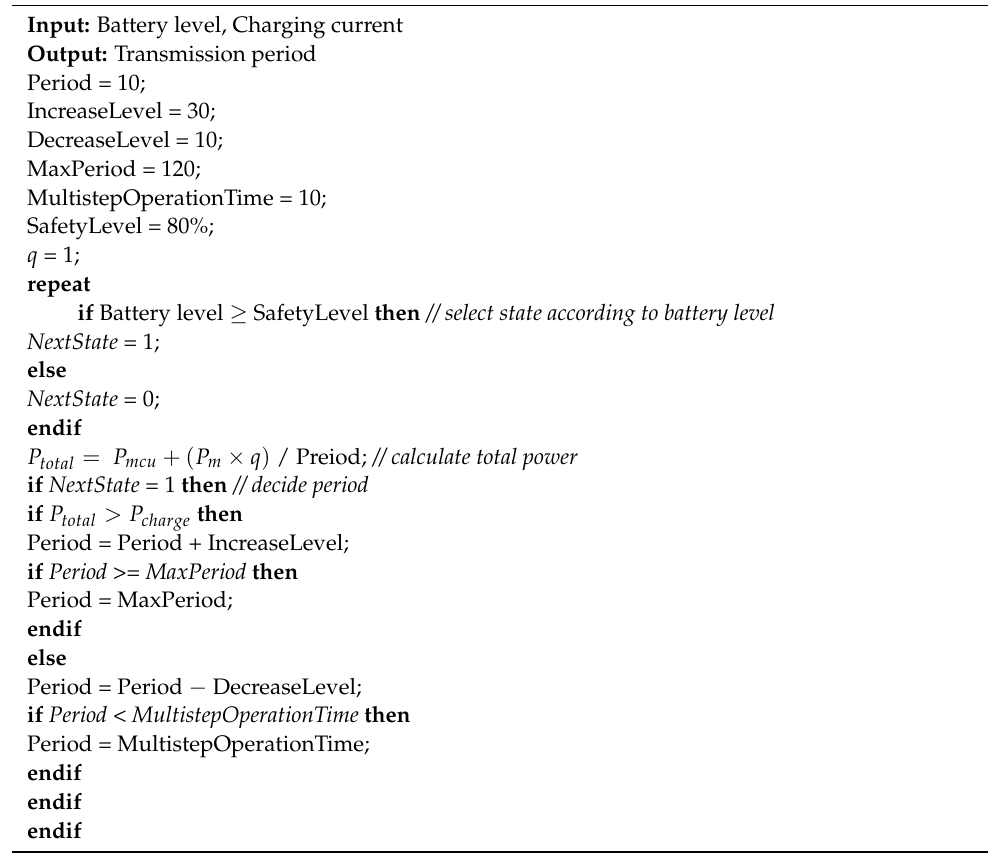
Algorithm 1 : Period of computation of power self-optimizing